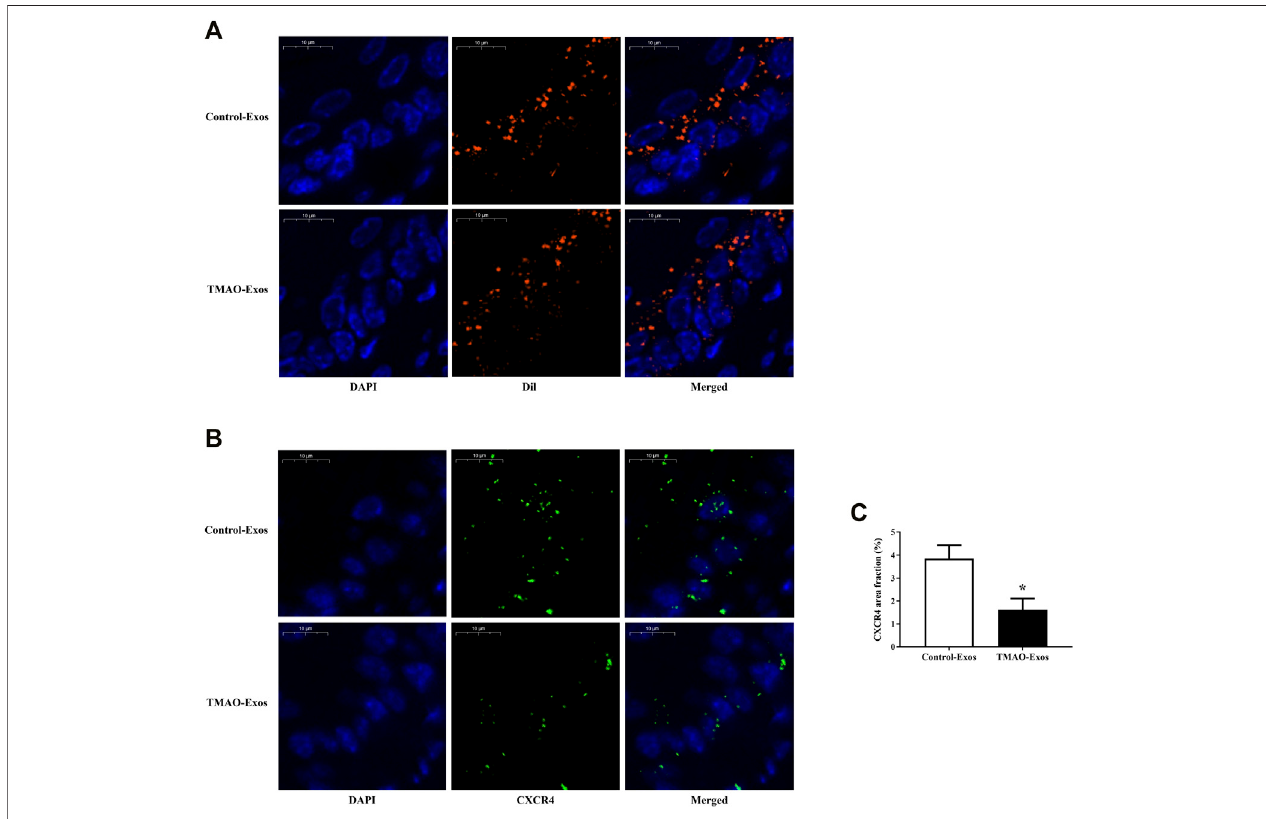
FIGURE 3 | TMAO-Exos distributed and reduced CXCR4 levels in the aorta. (A) Representative photographs of the localization of DiI-labelled Exos in the aorta. Exos from both groups were mainly enriched in endothelial cells. Nuclei were stained with DAPI. Bar: 10 μ m. (B,C) TMAO-Exos signi fi cantly reduced CXCR4 expressions. Nuclei were stained with DAPI. Bar: 10 μ m. All data were expressed as mean ± SEM. n = 3, independent t -test was performed for comparisons; * p < 0.05 versus